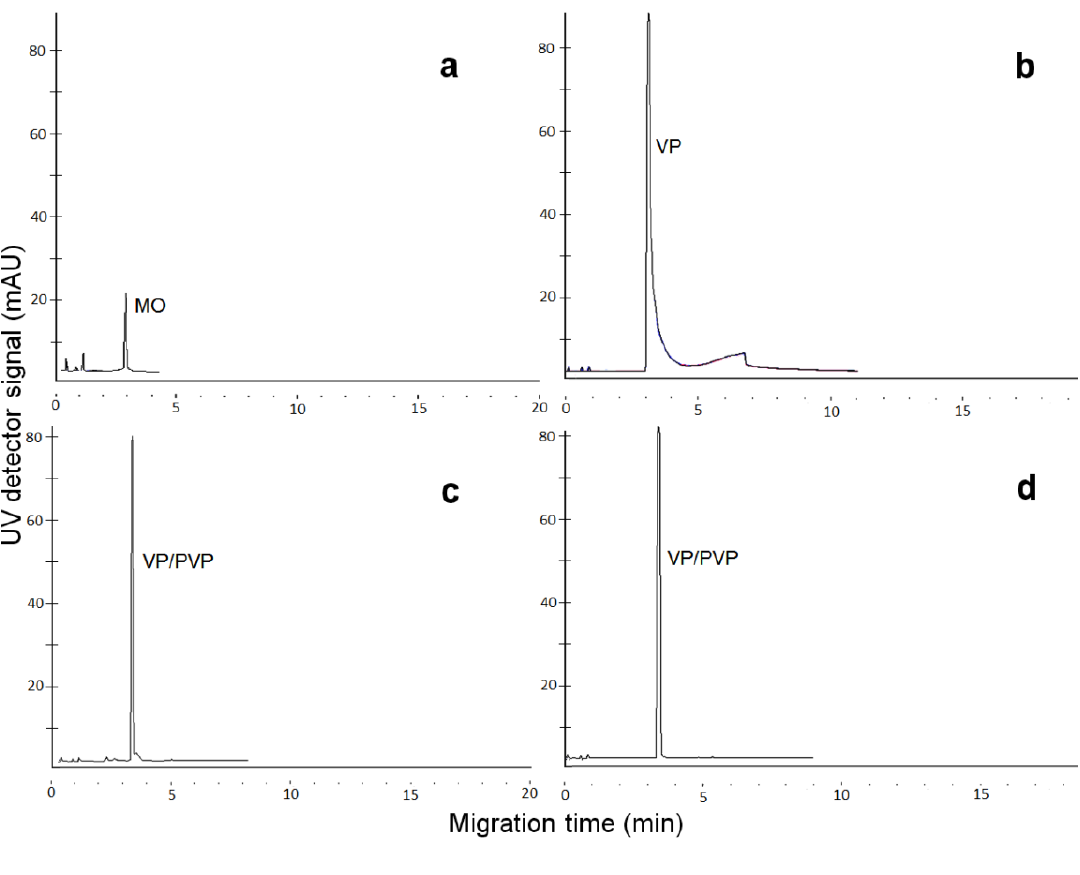
Figure 6. Capillary electrophoresis with ultra-violet detection (CE-UV) electropherograms